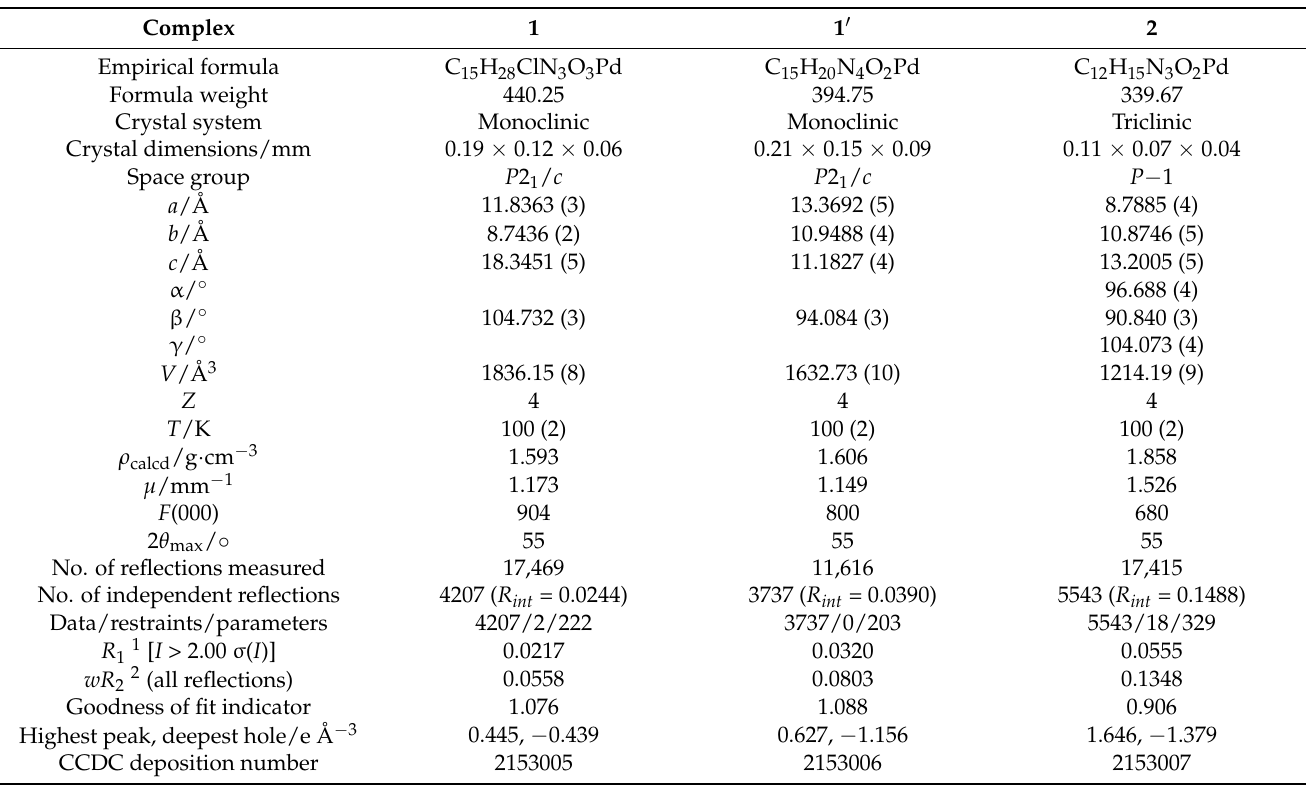
Table 4. Crystallographic data and refinement parameters of 1 (cid:48) and 2